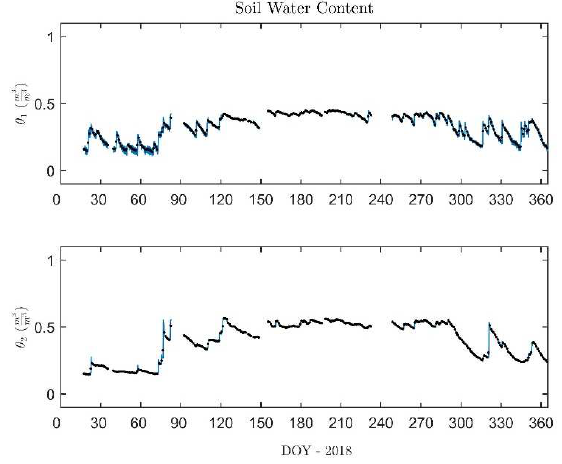
Figure 2. Measured soil temperature ( T 1 = − 0.05 m, T 2 = − 0.15 m and T 3 = − 0.25 m); soil heat flux ( G 1 = − 0.10 m and G 2 = − 0.20 m); and soil water content ( θ 1 = − 0.05 m and θ 2 = − 0.10 m). The blue line represents half-hour data and the black line represents daily average data.